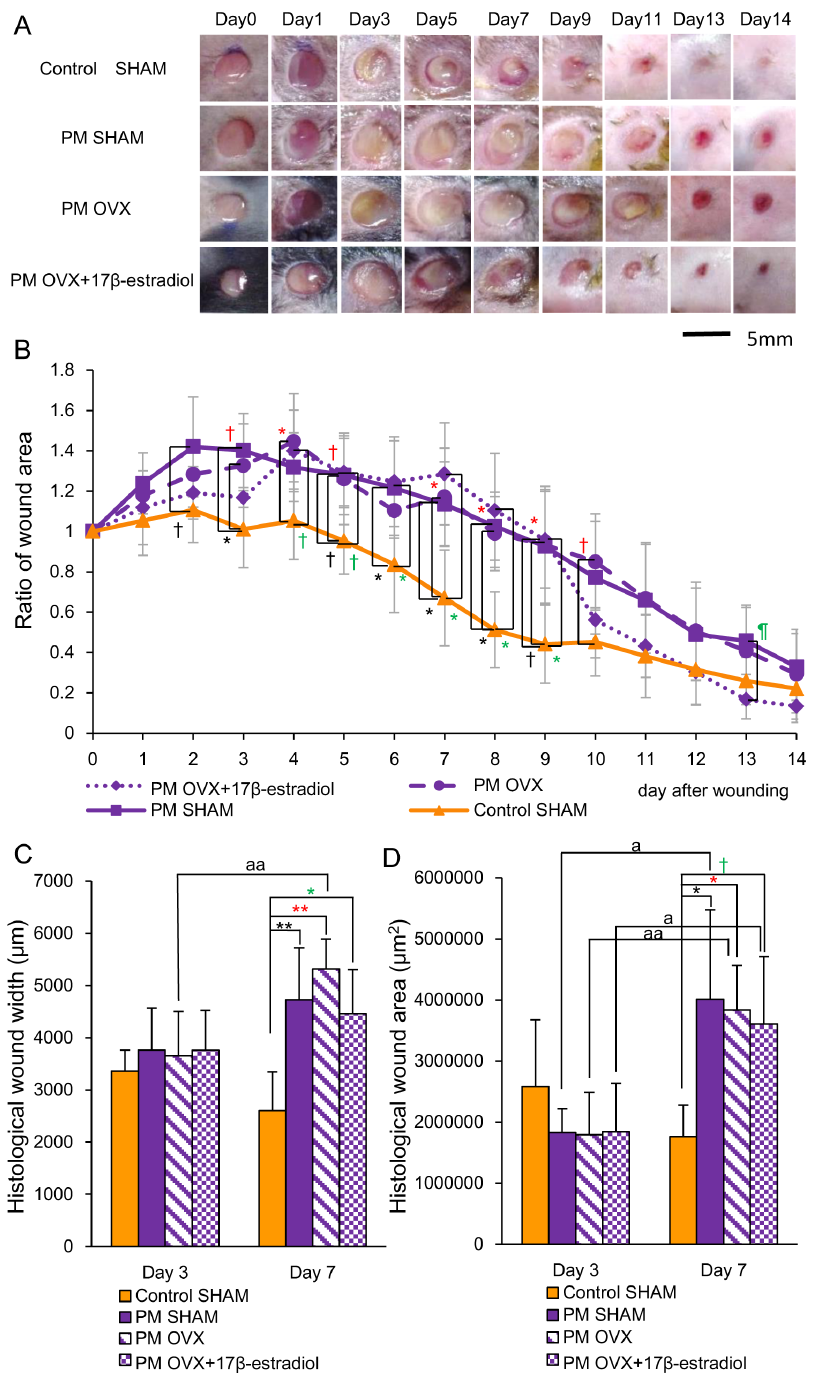
Fig. 3. Macroscopic wound healing and histological wound width and wound area. (A) Four-mm- diameter wounds were inflicted and healing was recorded by photography. Bar, 5 mm. (B) Ratios of wound areas to initial area on day 0 are shown on line graphs for each day. (C) Histological wound width ( m m) and (D) histological wound area ( m m 2 ) are shown on box graphs. Values are expressed as mean ¡ SD, n 5 4–6 for each group, ANOVA, Tukey-Kramer { p , 0.1, * p , 0.05, ** p , 0.01 (in black): Control SHAM versus PM SHAM, { p , 0.1, * p , 0.05, ** p , 0.01 (in red): Control SHAM versus PM OVX, { p , 0.1, * p , 0.05 (in green):